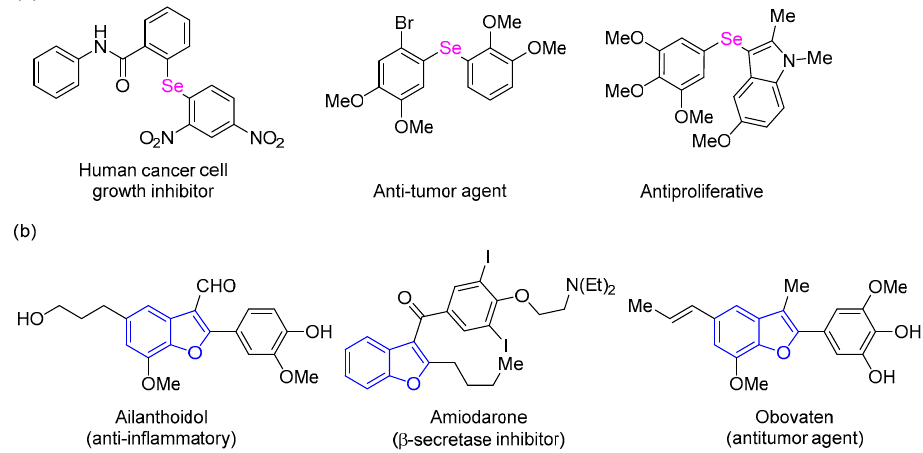
Figure 1. Representative biologically active molecules. ( a ) Selected examples of bioactive compounds containing selenium. ( b ) Representative biologically active molecules containing benzofuran motif.